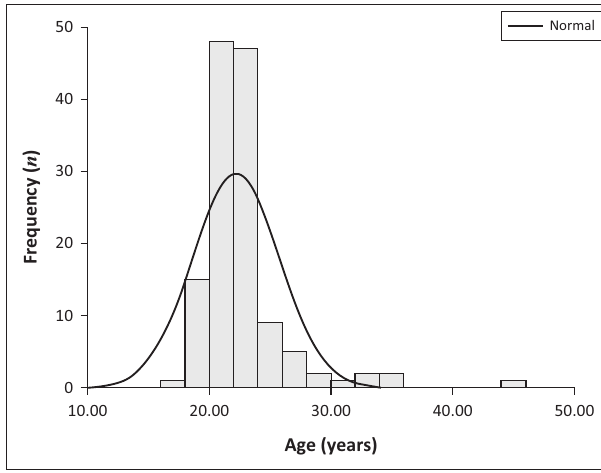
FIGURE 1: Study population age distribution graph.